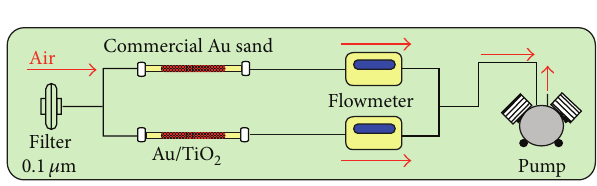
Figure 3: Schematic of sampling